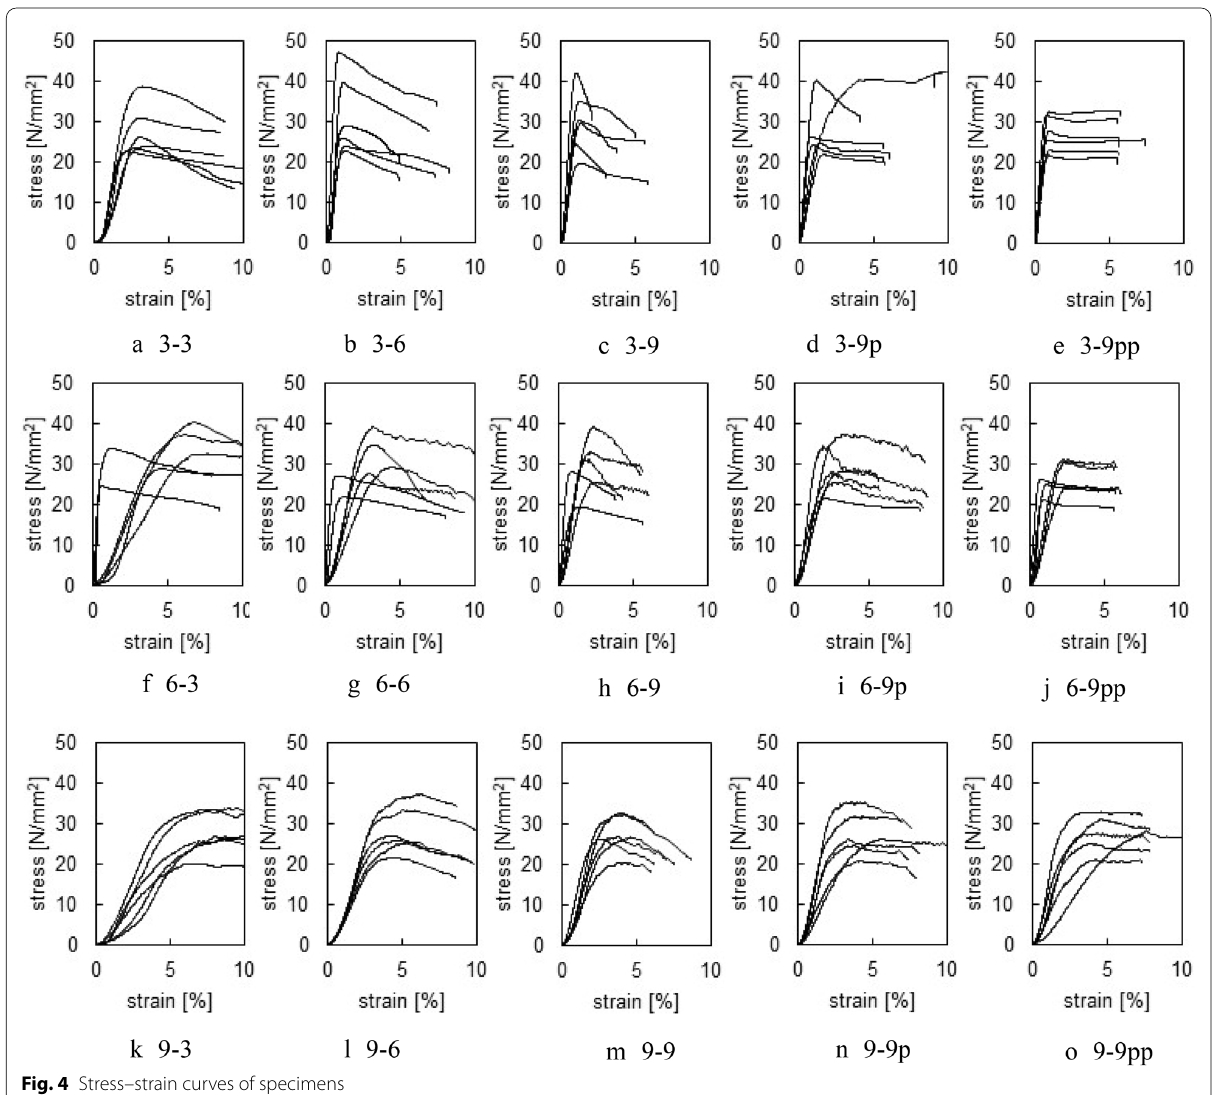
Fig. 4 Stress–strain curves of specimens